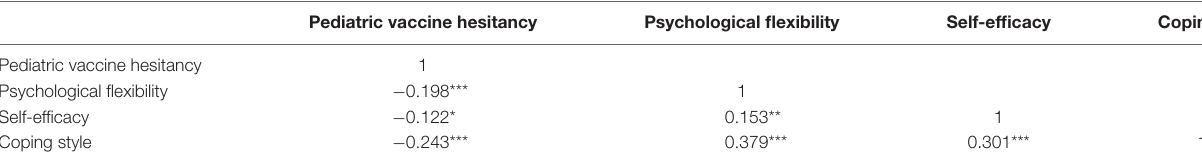
TABLE 1 | Correlation analysis between primary variables ( n = 382).